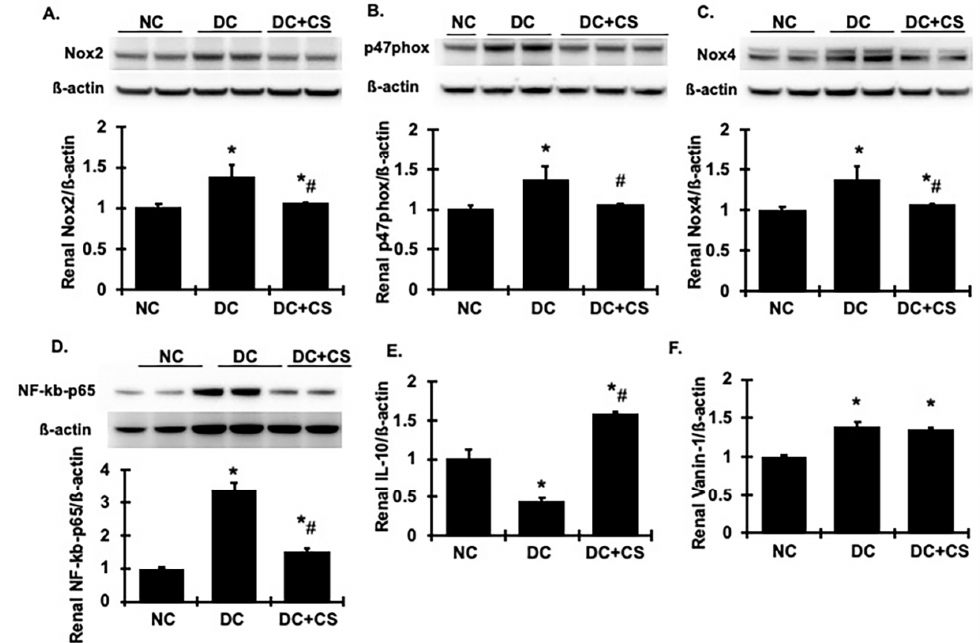
Figure 7. rBMSC sheets reduces renal oxidative stress and related renal information markers in CGN rats. ( A – D ) Representative Western blots illustrating Nox2 ( A ), p47 phox ( B ), Nox4 ( C ), NF-kB-p65 ( D ), and ß-actin protein expression in renal cortical tissues. The graphs summarize the results of band cortex tissue. Expression of mRNA was determined by real-time RT/PCR. Changes in mRNA levels